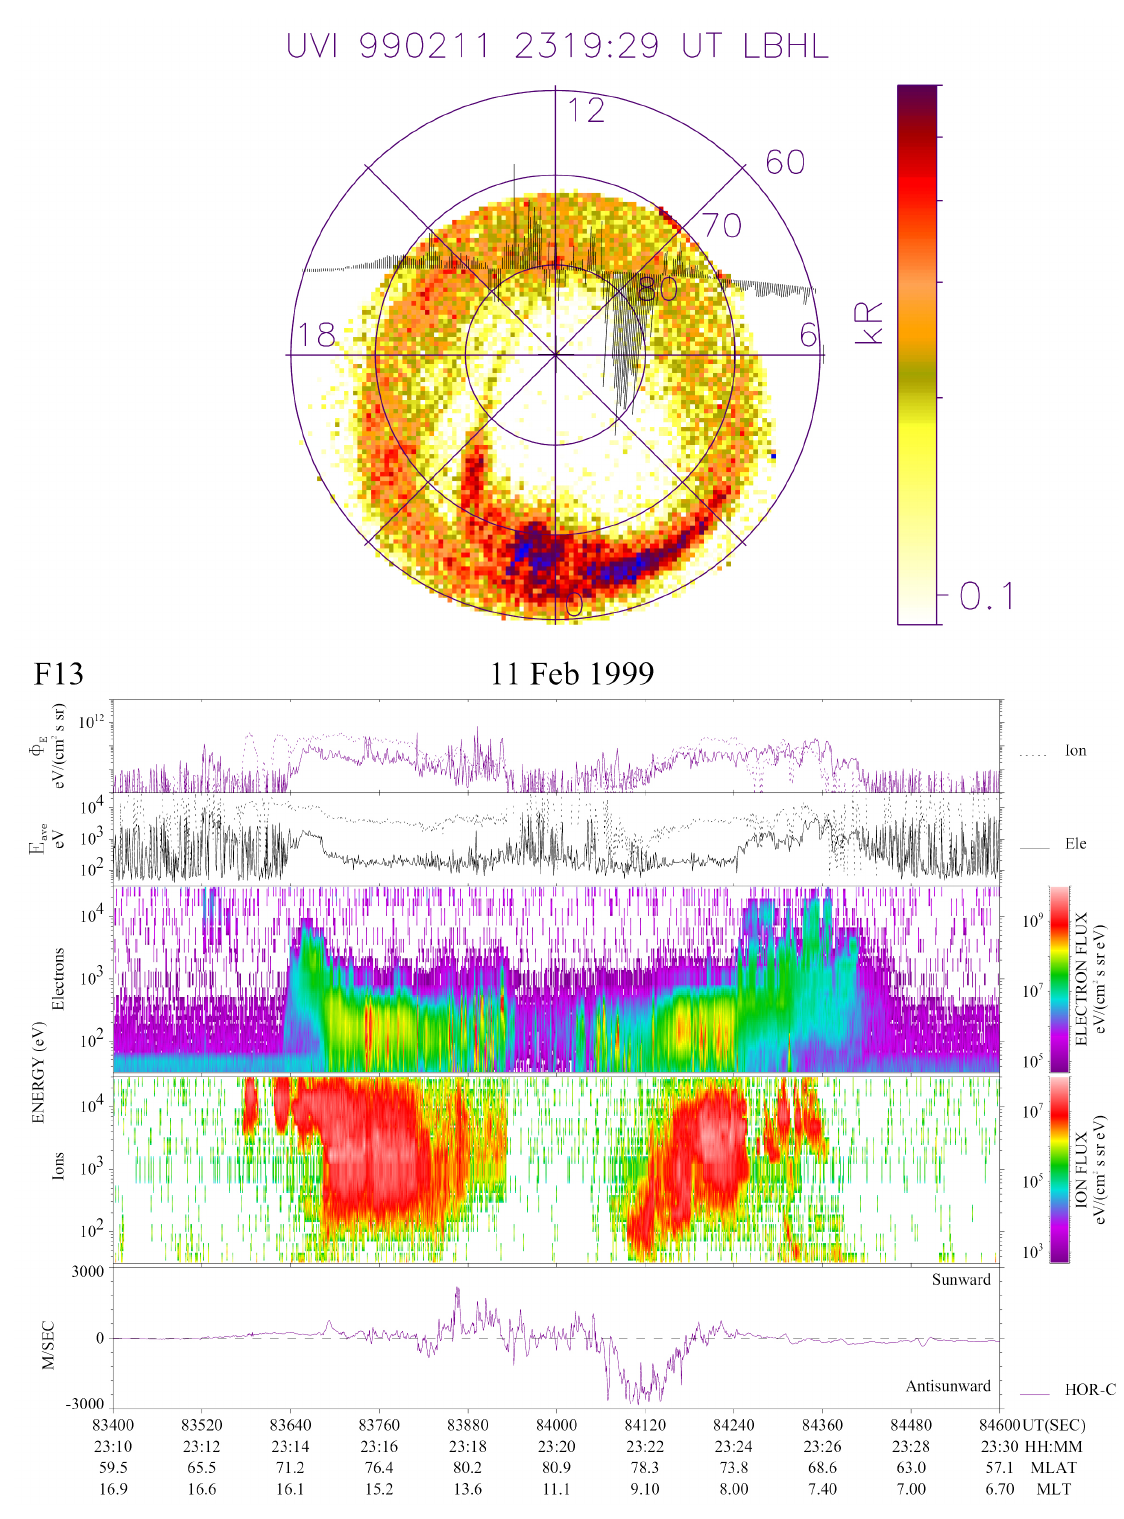
Fig. 9. Data shown from the third DMSP pass on 11 February 1999 (23:10–23:30 UT) that occurs during the UVI data period. Same format as Fig. 7. See text for